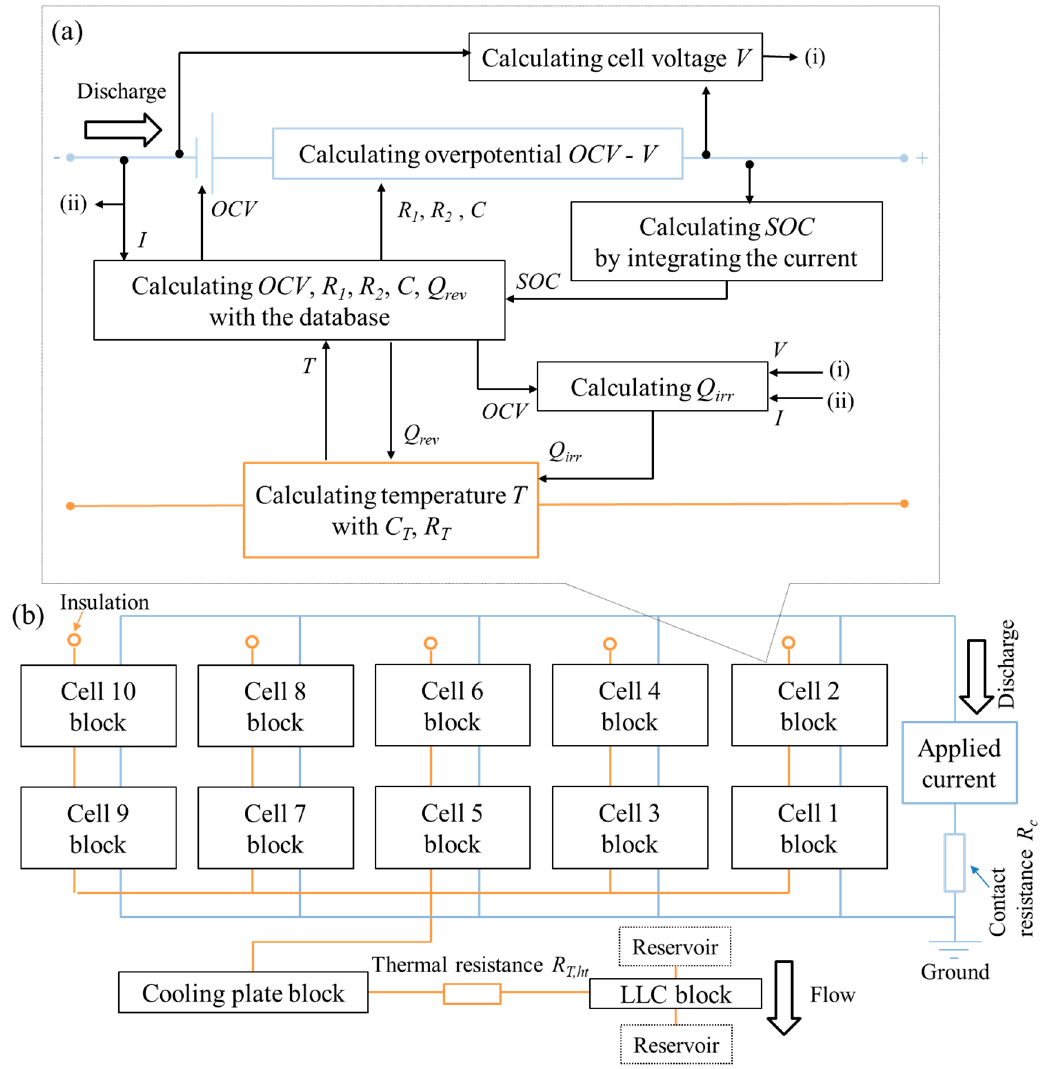
Figure 5. The schematic views of the electrical-thermal coupled ECM for ( a ) the single cell and ( b ) the whole battery pack. Note that the blue lines indicate the electrical links and the orange lines indicate the thermal links.